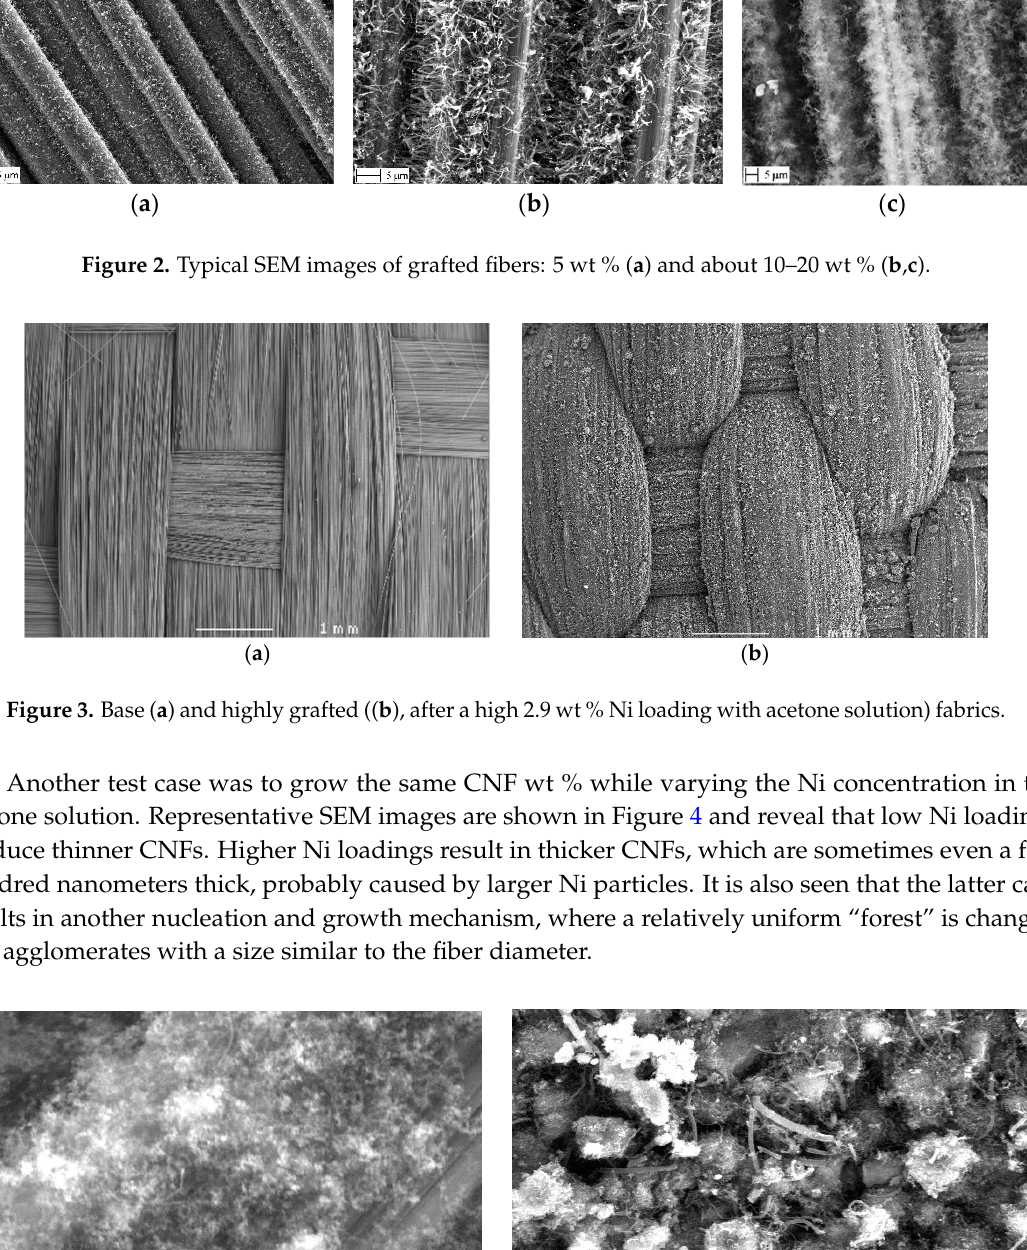
Figure 4. CNF “forests” after a relatively low (0.18 wt %, a ) or high (2.9 wt %, b ) Ni loadings.